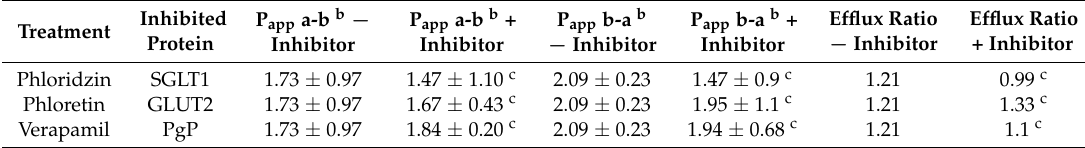
Table 3. Effect of various inhibitors on rate of transport of aspalathin (100 µ M).